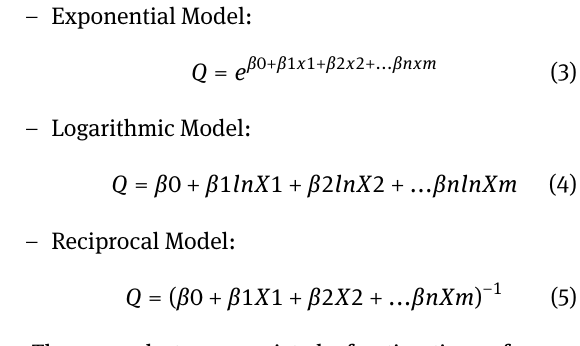
Figure 1: Study Area – Location of the surface catchment basin of Meia Ponte river where the fluviometers used in this study are located.